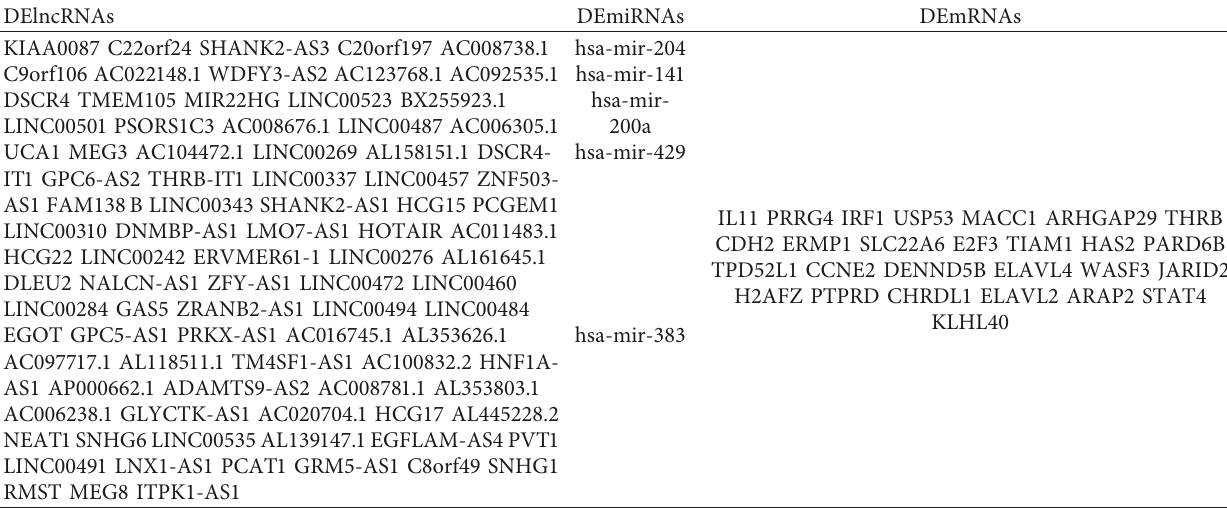
Table 2: The DERNAs enrolled in the ceRNA